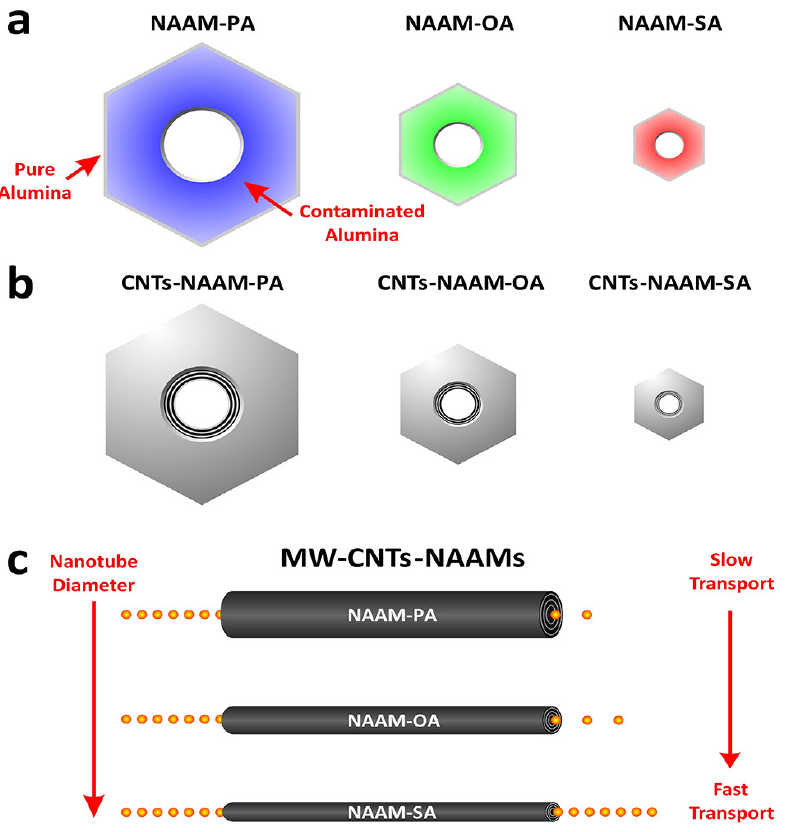
Figure 34. Schematic representation of the chemical composition of the fabricate PAA templates executed by Alsawat et al. [28]. ( a ) Different anion distributions on the Chemical composition of PAA templates are obtained using different electrolyte solutions, where PA, OA and SA refer to Phosphoric Acid, Oxalic Acid and Sulfuric Acid, respectively. ( b ) Fabricated PAA/CNTs assemblies after the CVD process, and ( c ) transport through PAA/CNTs assemblies depending on the geometrical PAA feature. Reprinted with permission from Ref. [28]. Copyright © 2023 the American Chemical Society.